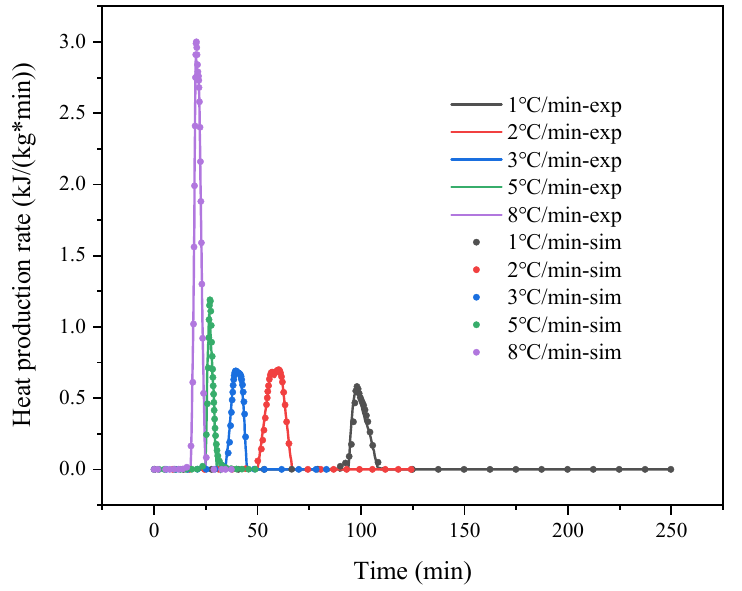
Figure 11. Evolution of heating production rate of PSS + (NH 4 ) 2 SO 4 thermal decomposition reaction with time in experiment and simulation. Table 6. Thermokinetic evaluation of the multistage reaction models of PSS + (NH 4 ) 2 SO 4 .